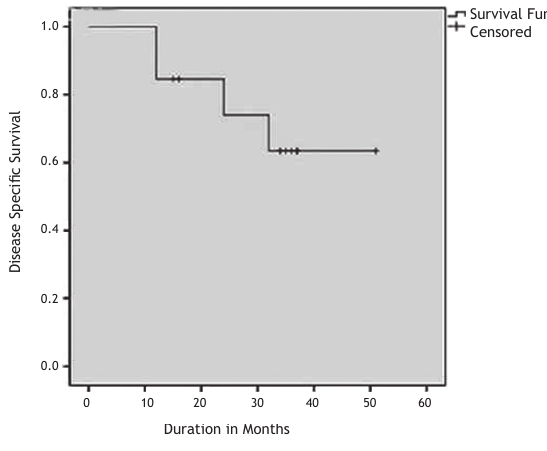
Figure 1 Kaplan Meier survival curve showing disease-specific survival for 13 patients.